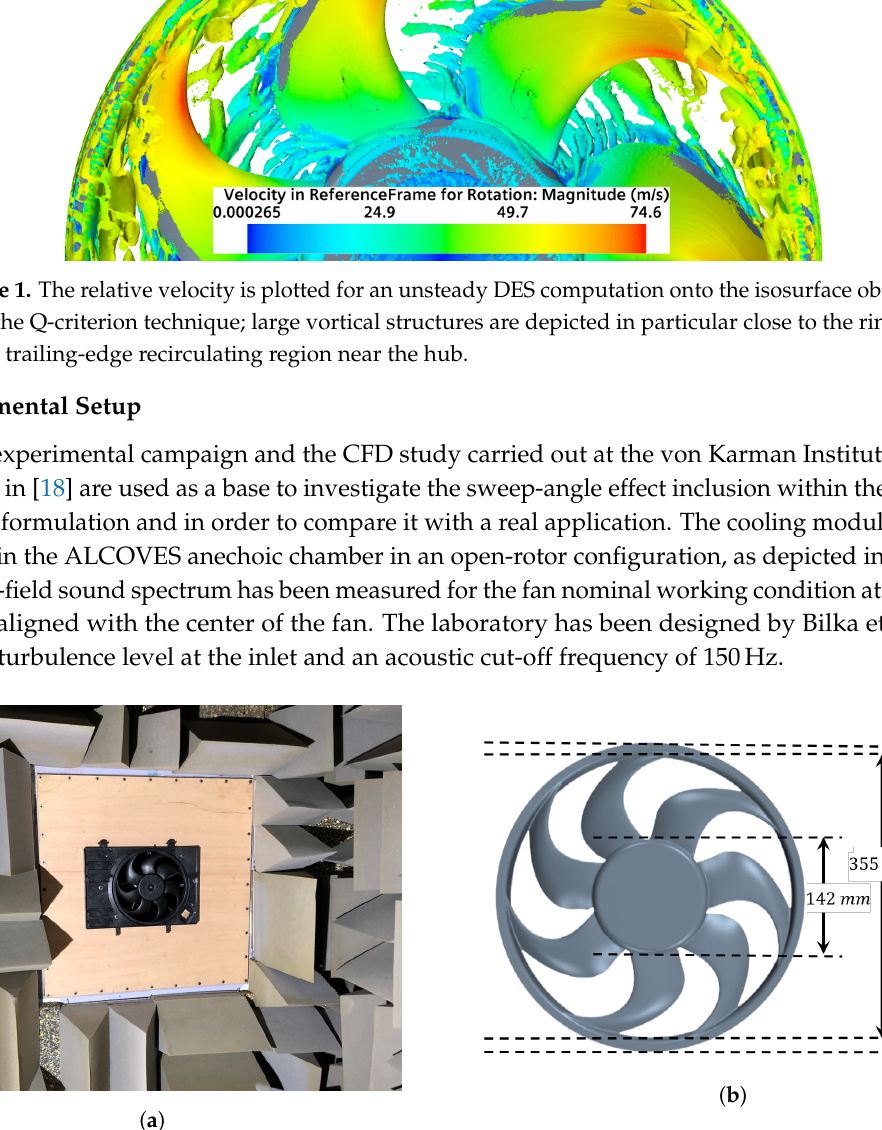
Figure 2. ( a ) ALCOVES anechoic chamber: upstream room with B&K microphones and open-rotor configuration from [18]. ( b ) Suction-side 3D CAD model of the Valeo forward-skewed fan employed in the steady RANS